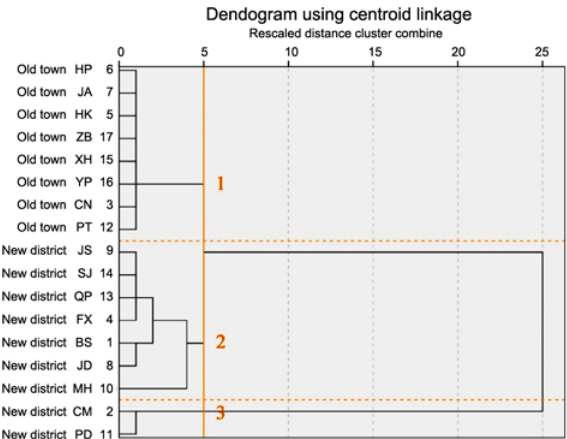
Note . The abbreviations of districts are explained in Figure 1. Fig. 6. Cluster analysis of selected